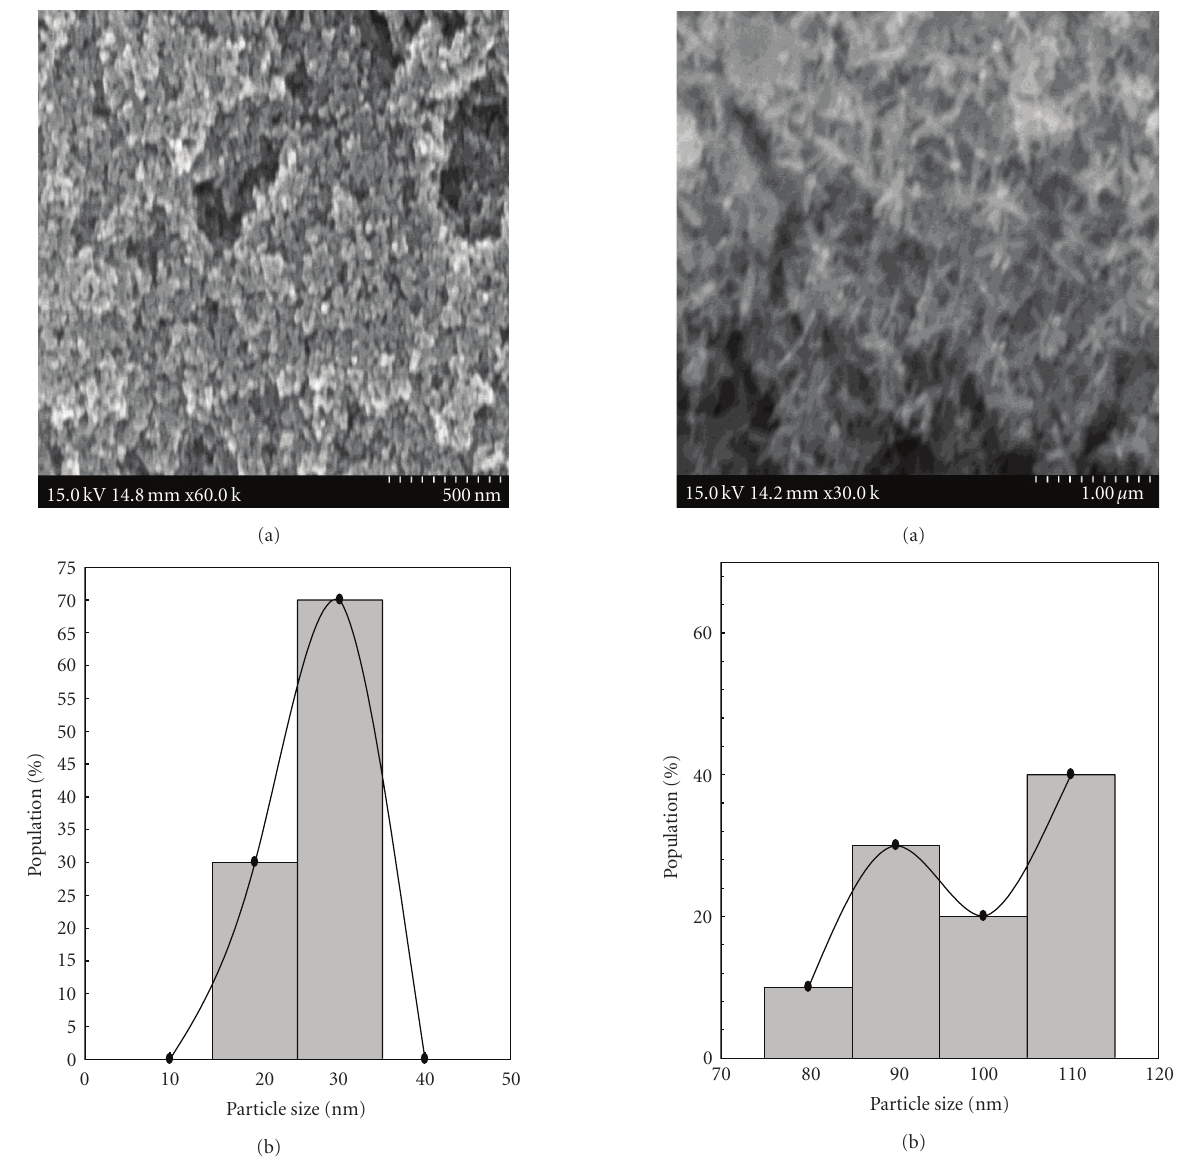
Figure 4: TTIP-TiO 2 thin film morphology after annealing at 500 ◦ C.